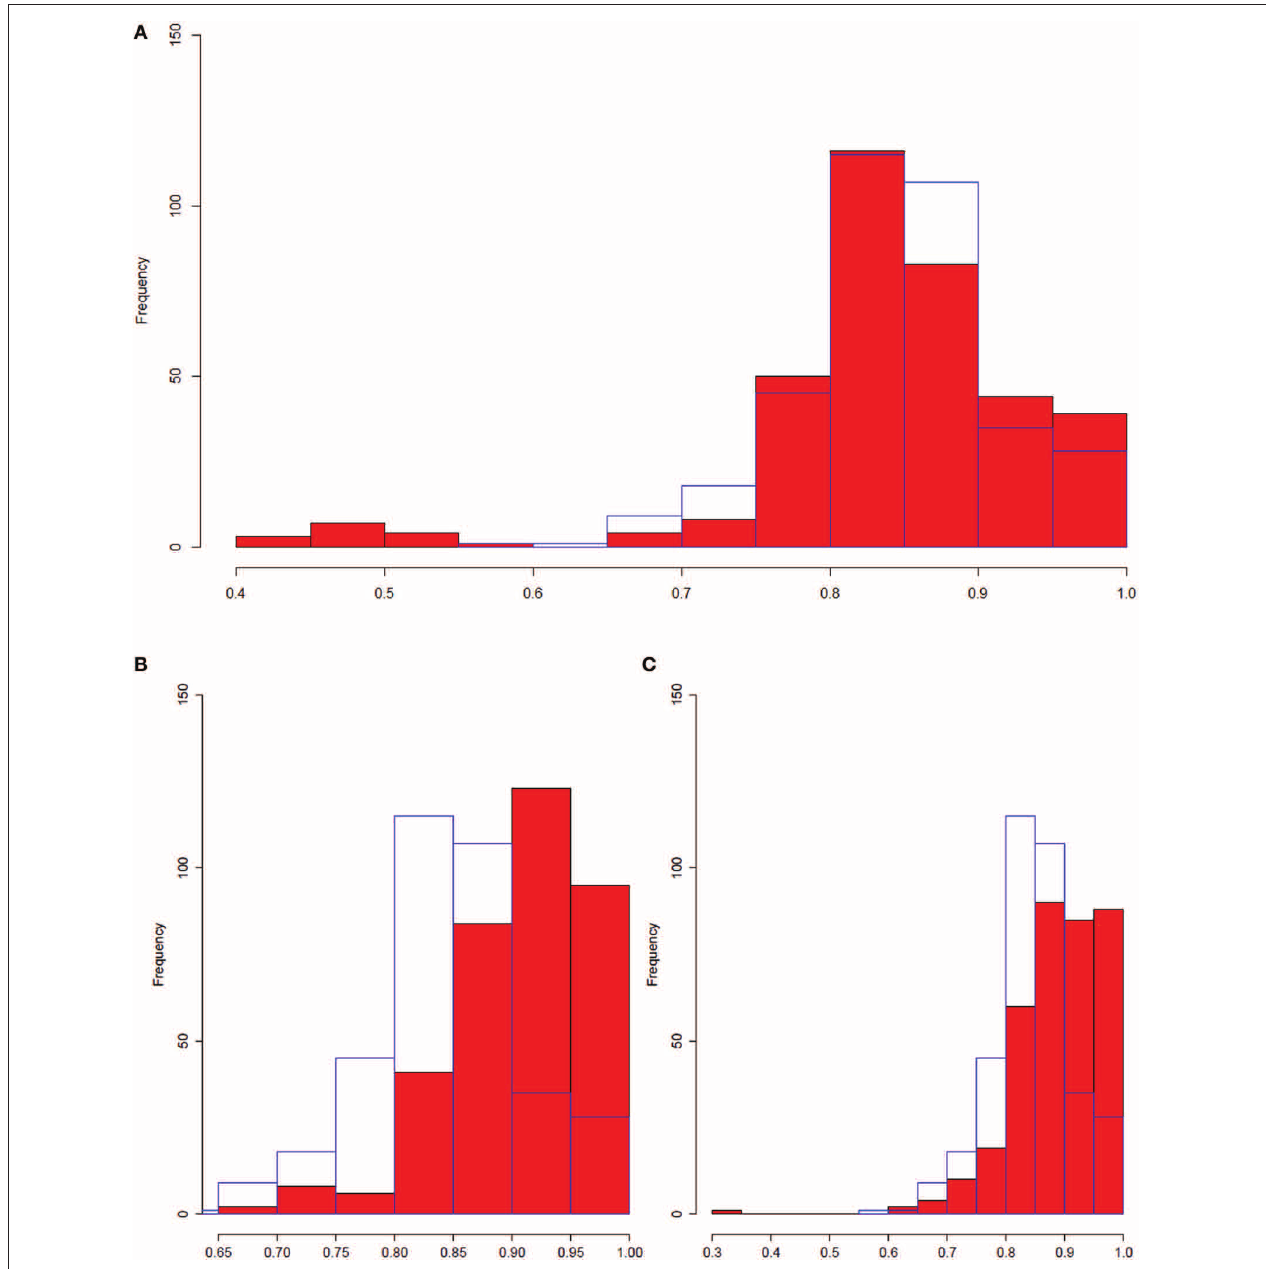
FIGURE 9 | The entire macrophage dataset has a greater number of non-linear interactions. Histograms comparing distributions of Pearson correlations for interactions with high ( > 0.9) MIC scores. All distributions were sampled such that there were 360 entries for each entry. The blue border in each part of the figure is the liver dataset. (A) Full macrophage